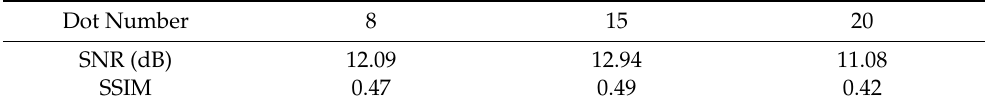
Figure 7. H OBJ and reconstructed images for different H PSF . ( a – c ) are associated with 8, 15, and 20 dots, respectively; ( d – f ) are the corresponding reconstructed images. Table 1. Comparison of the reconstructed images for different H PSF